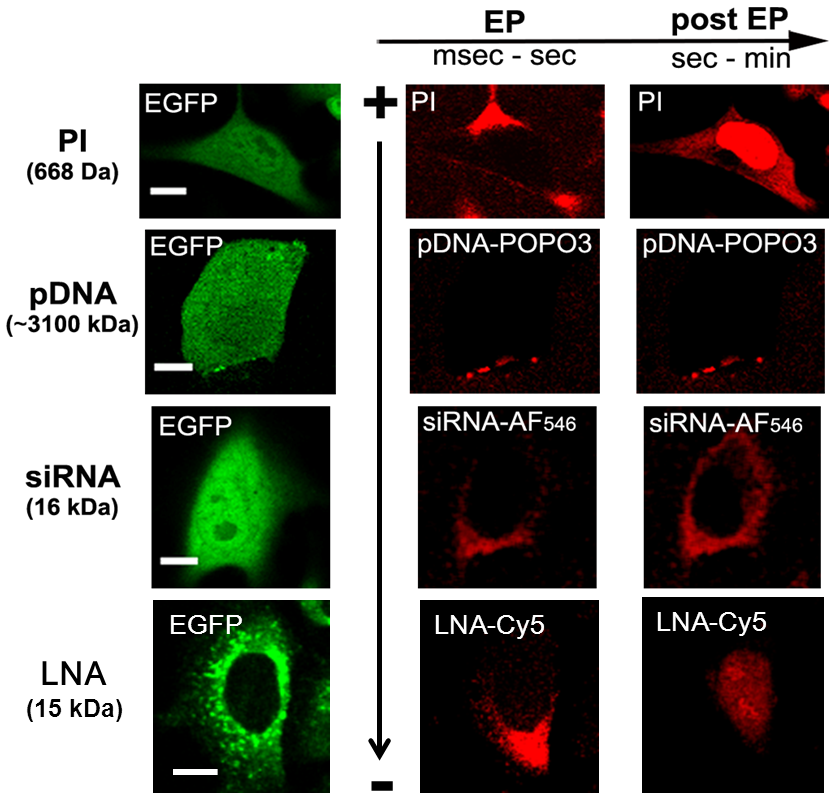
relocalization. The pictures on the left represent stably transfected cells with GFP (adapted from references